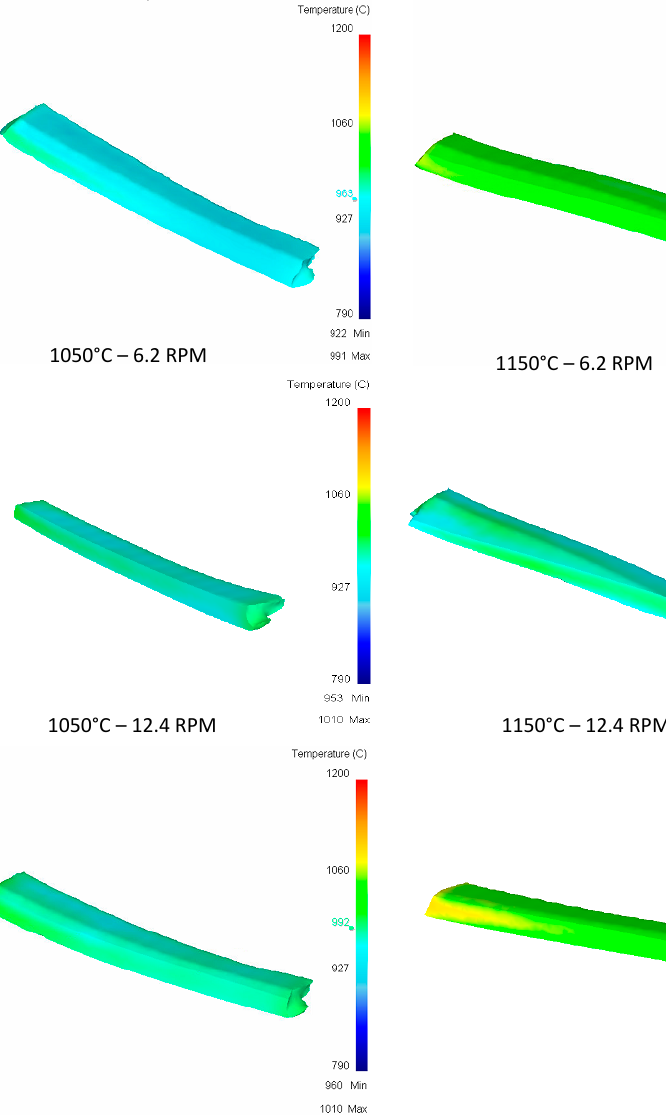
Figure 15. Upper Rail temperature graph for second pass. Pass 3: